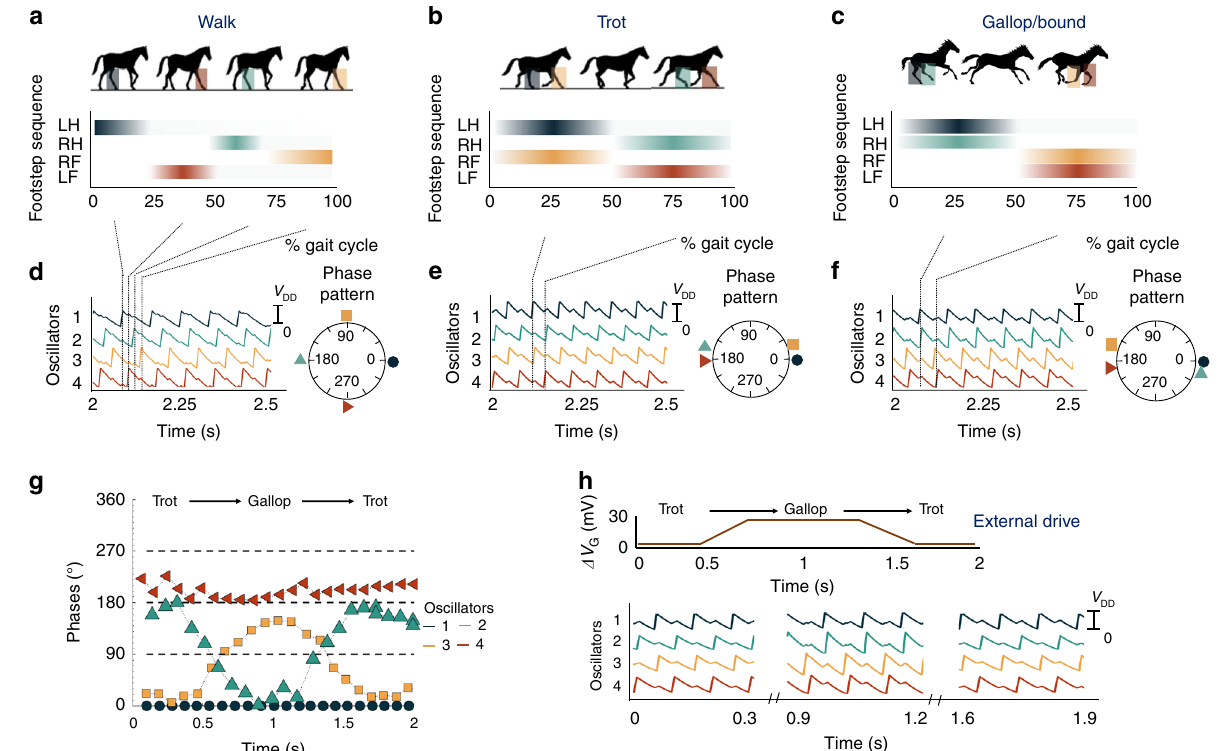
Fig. 4 a – c Typical gait pattern of a quadruped characterized by distinctive phase patterns. Here, LH: left hind; LF: left front; RH: right hind; and RF: right front. d – f Experimentally obtained spatiotemporal dynamics of the oscillator network and the corresponding generated phase patterns using different biasing schemes of V G of the series transistors. Walking gait is realized by utilizing the biasing conditions of scheme 1 ( V G,2 = V G,1 , V G,4 = V G,3 ) and setting Δ V = V − V = 15 mV. Trotting gait is realized by applying V = 1.19 V to all the series transistor gates. Galloping or bounding gait is realized by G ( G,1 G,3 ) G scheme 2 bias scheme with Δ V G = 30 mV. g , h Measured dynamic modulation of the spatiotemporal pattern using change in Δ V G allowing seamless adaptive gait transition between a trot and a gallop. A smooth transition in the phase pattern between a walk and a trot upon applying a Δ V G = 30 mV using scheme